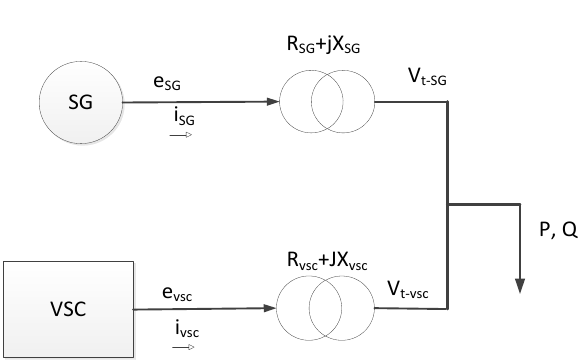
Figure 7. Voltage droop control for parallel connected voltage-control units.